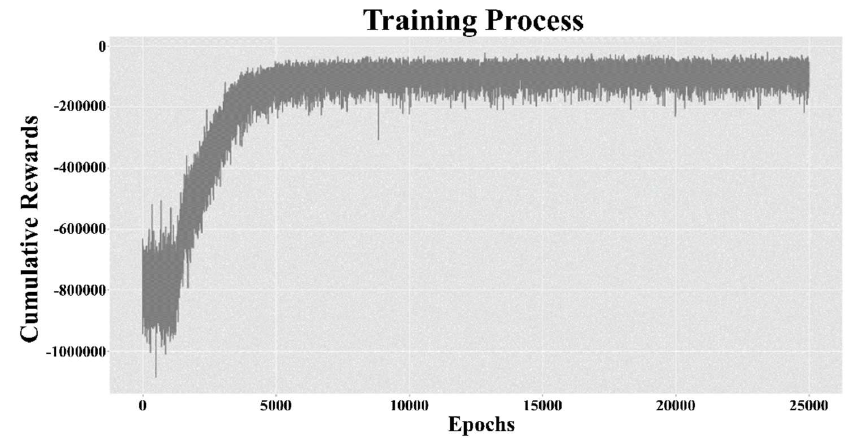
Figure 7. Training process of the deep Q-network (DQN).